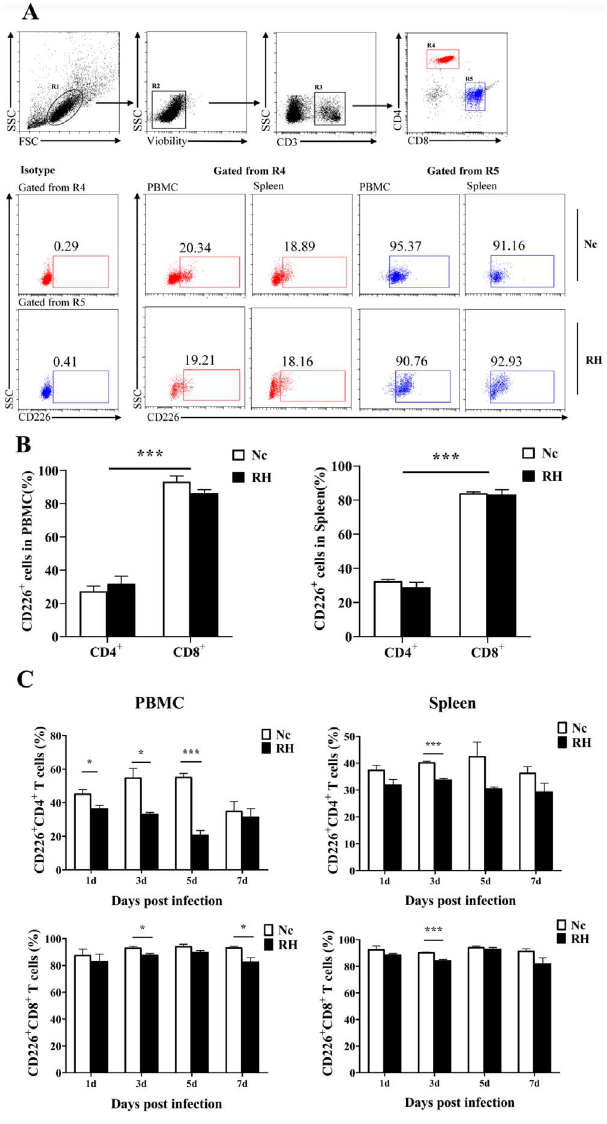
Figure 2. Changes in CD226 expression on T cells in different tissues after T. gondii infection. (A) Proportions of CD226 + cells among CD4 + T and CD8 + T cells in T. gondii- infected (RH) and normal mice (Nc) at 7 days after infection. (B) Results of statistical analysis of the percentage of CD226 + cells among CD4 + T and CD8 + T in RH and Nc mice at 7 days after infection. (C) Dynamic changes in the percentages of CD226 + T cells at different time points. The results are representative of three independent experiments with fi ve mice in each group per experiment, with data denoting means ±